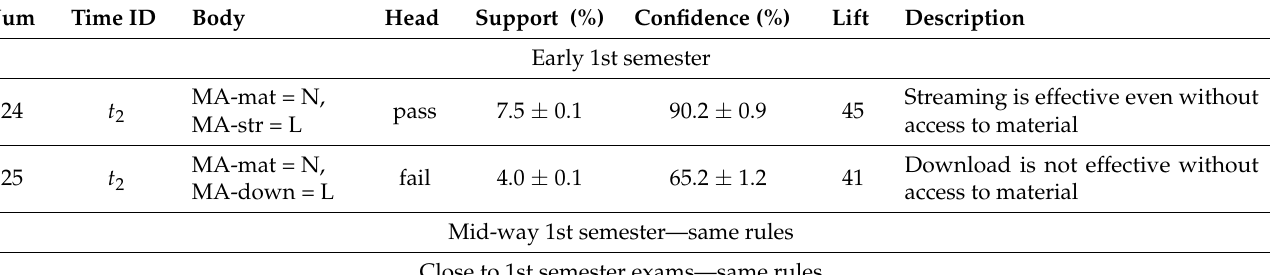
Table 9. High-quality mixed-feature rules mined from the MA datasets. minsup = 1%, minconf = 50%, mincorr = 2. Support and confidence values of each of the selected rules are averaged over the 5 cross-validation folds (average and standard deviation are